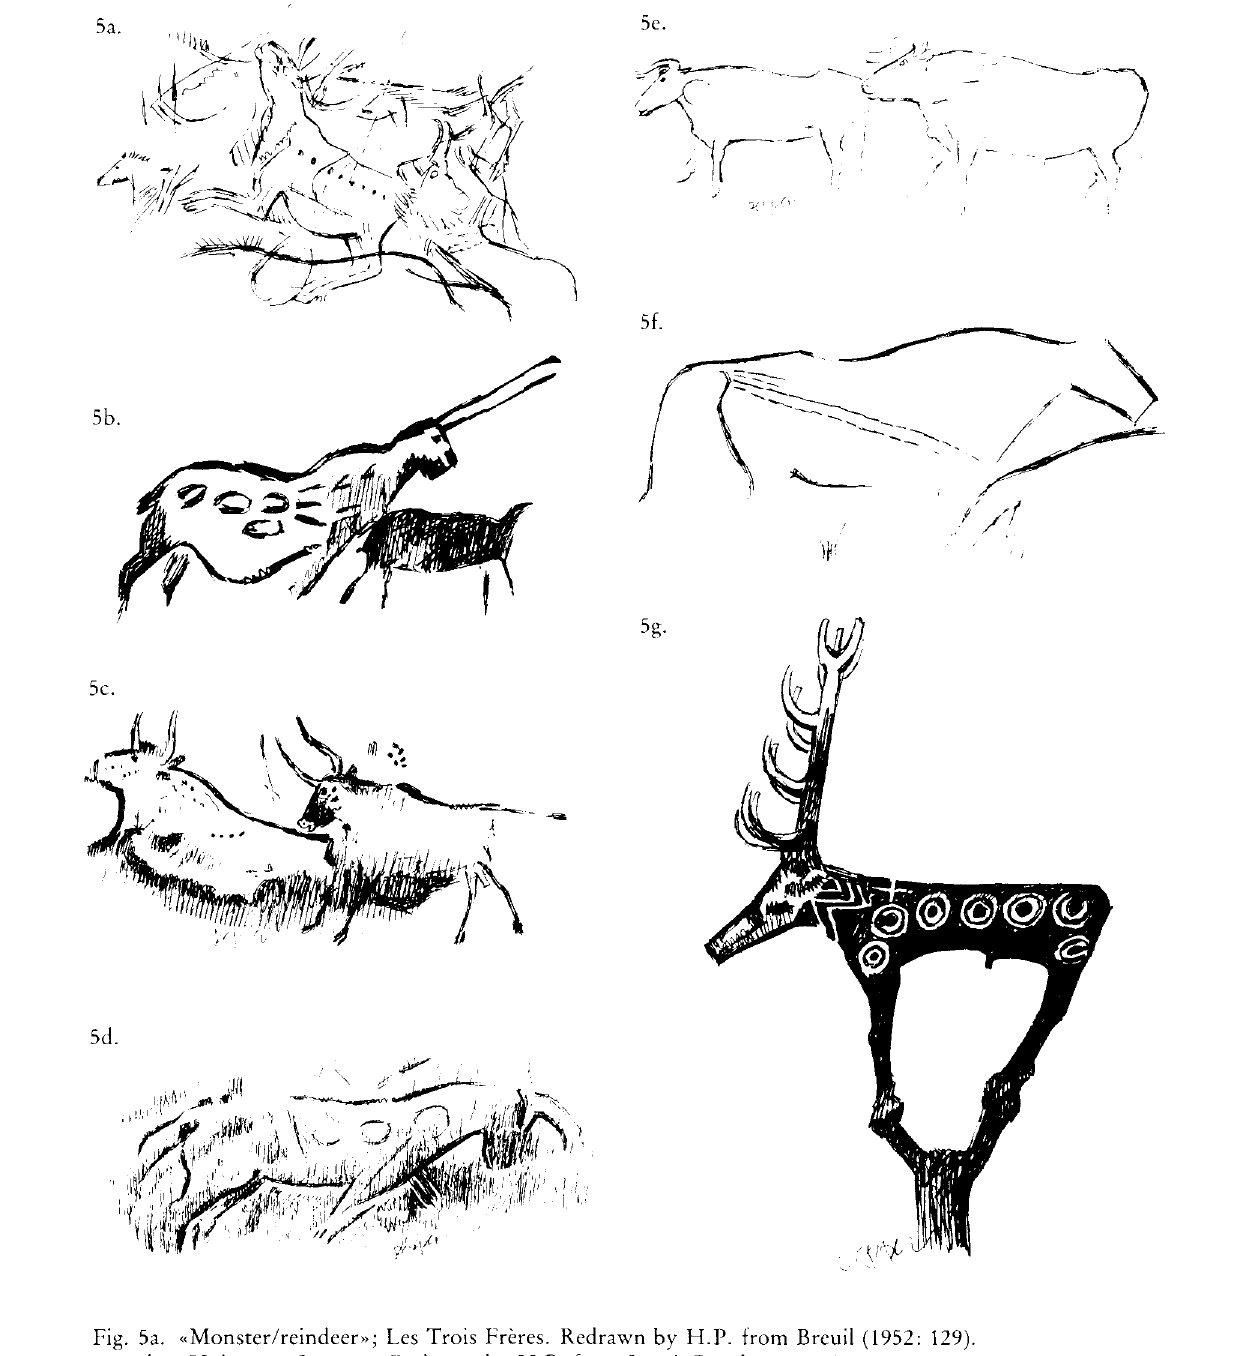
Fig. 5a. «Monster/reindeer»; Les Trois Frères. Redrawn by H.P. from Breuil (1952: 129). b. «Unicorn»; Lascaux. Redrawn by H.P. from Leroi-Gourhan (1968). c. Spotted aurochs cow (?) bearing a row of spots, and a bull; Lascaux. Redrawn by H.P. from Leroi-Gourhan (1968: